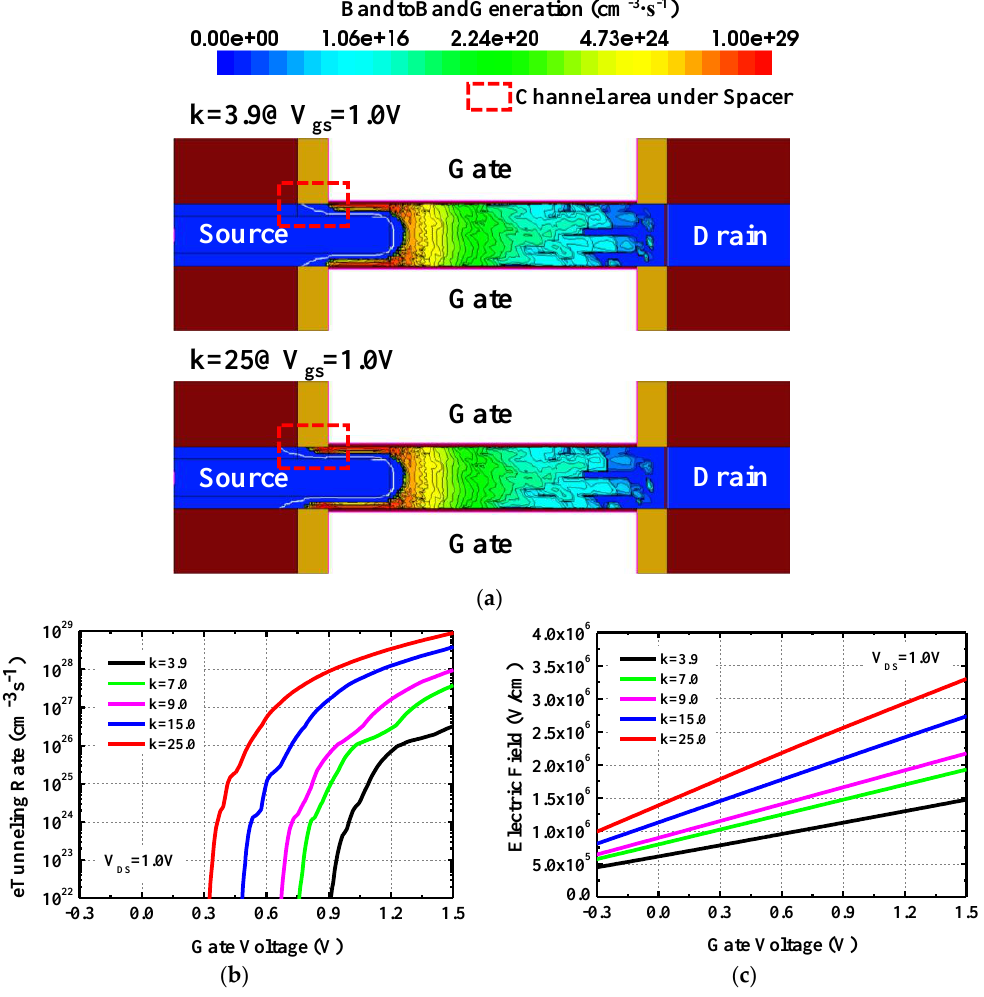
Figure 3. ( a ) Two-dimensional (2D) contour mapping of electron tunneling rate at V GS = 1.0 V for the spacers with κ = 3.9 and κ = 25. ( b ) Averaged electron tunneling rate, and ( c ) averaged electric field at V DS = 1.0 V in the channel region under the spacer.